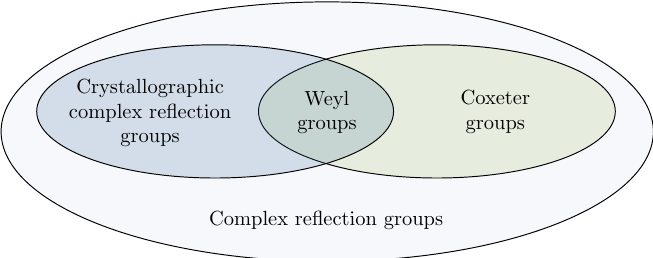
Figure 1 . Euler-Venn diagram depicting the relations among complex re(cid:13)ection groups, crystallo- graphic complex re(cid:13)ection groups, Coxeter groups, and Weyl